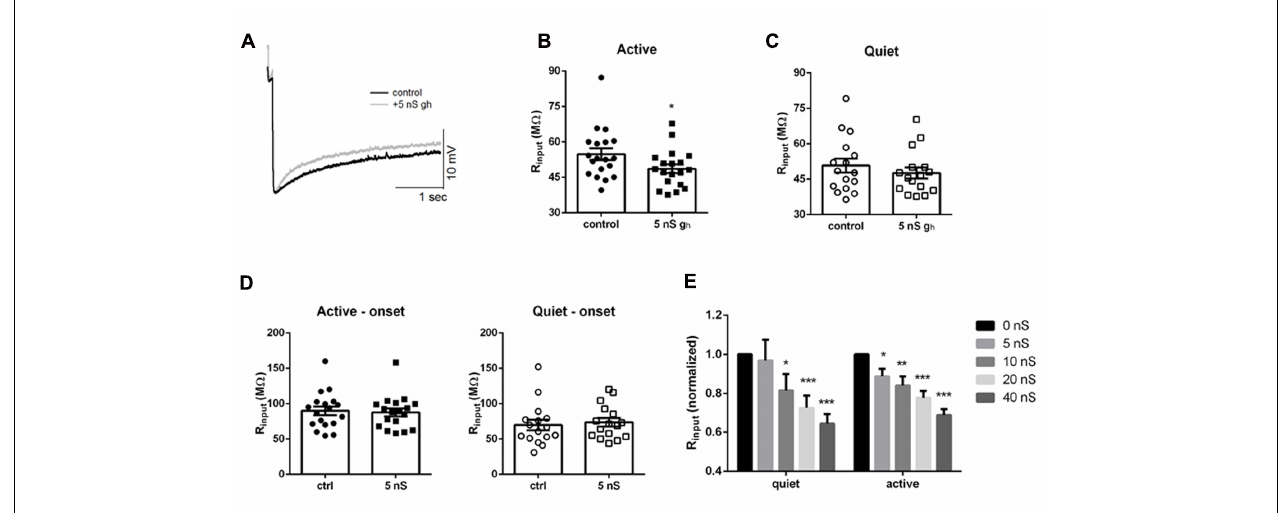
FIGURE 5 | Injecting artificial g h affects differentially membrane input resistance of DCN fusiform quiet and active neurons. (A) Example of the effect of injecting 5 nS of artificial g h on the response to hyperpolarizing current in a fusiform neuron. (B) Summary of the effect of injecting 5 nS of artificial g h on the membrane input resistance of DCN fusiform active neurons. ∗ p < 0.05. (C) Summary of the effect of injecting 5 nS of artificial g h on the membrane input resistance of DCN fusiform quiet neurons. (D) Effect of 5 nS artificial g h on the immediate membrane input resistance of fusiform neurons. (E) Effect of application of increasing artificial g h on the normalized membrane input resistance of quiet and active neurons ( n = 7 each). ∗∗ p < 0.01; ∗∗∗ p <